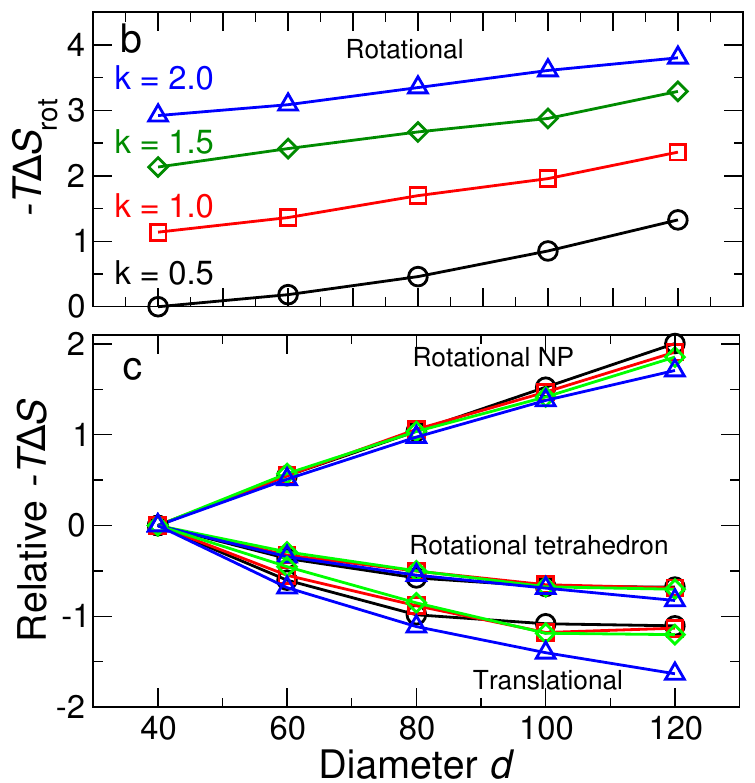
Figure 9. ( a ) The change in the translational free energy − T ∆ S trans as a function of NP diameter for many stiffness values. The free energy is reported relative to the reference system ( d = 40 σ and stiffness k a = 0.5). ( b ) The change in the total rotational free energy − T ∆ S trans . ( c ) The translational free energy and rotational free energy of NPs and tetrahedral cages as a function of NP size. Different stiffness values are plotted relative to the smallest NP with the same stiffness, to eliminate shifts of free energy due to changes of stiffness. The systems with different stiffness have the same behavior as a function of NP size, suggesting that the DNA stiffness just shifts the free energy by a